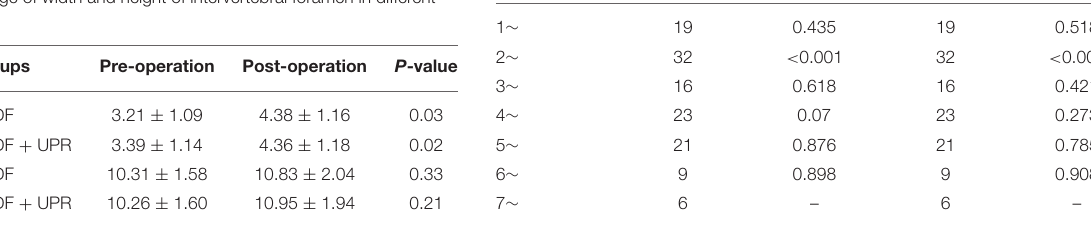
Each subgroup is compared to the next subgroup using two-sided t test. wIVF, width of intervertebral foramen; JOA, Japanese orthopedic association; VAS, visual analog scale. P < 0.05 is considered as significant.